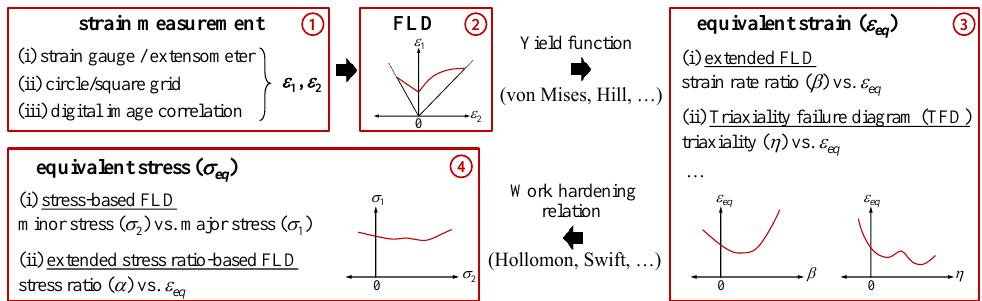
Figure 1. Schematic diagram of the procedure to determine path-independent forming limit criteria.